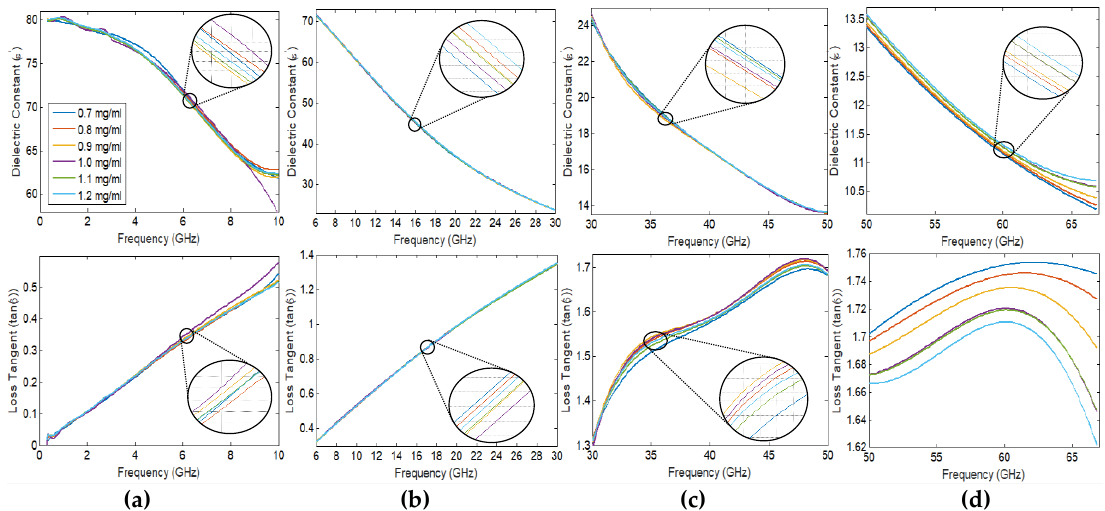
Figure 2. Dielectric measurements (dielectric constant and loss tangent) of glucose-loaded solutions at different frequency bands: ( a ) 300 MHz–10GHz; ( b ) 6–30 GHz; ( c ) 30–50 GHz; ( d ) 50–67 GHz.